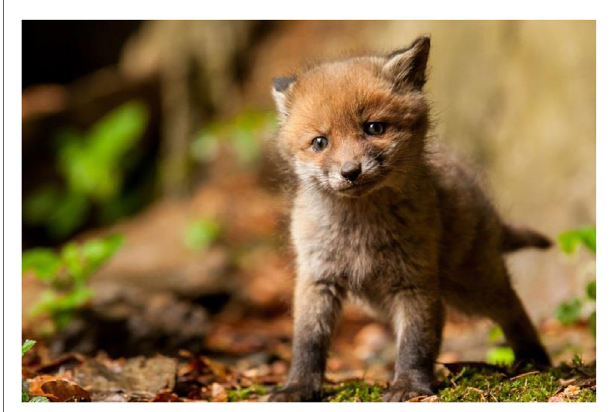
FigUre 1 | Sample picture of a young fox shown in the photographs condition (this photograph is being reproduced with the permission of the copyright holder, Uwe